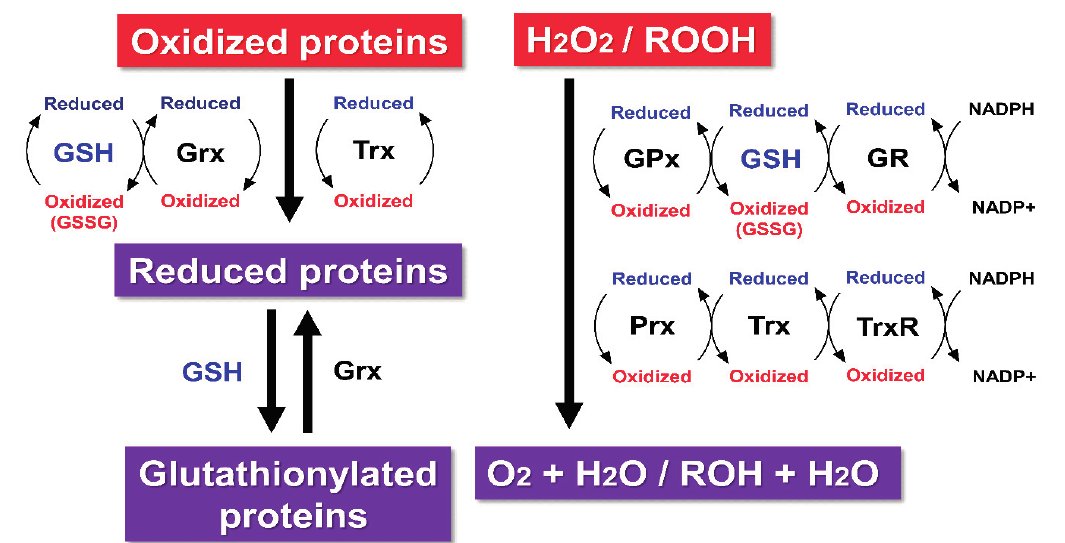
Figure 1. Regulation of the redox homeostasis by glutathione (GSH), thioredoxin (Trx), and glutaredoxin (Grx) systems. Hydrogen peroxide (H 2 O 2 ) and hydroperoxides (ROOH) are catalyzed by GSH peroxidase (GPx) or peroxiredoxin (Prx) to alcohols (ROH) and water. The oxidized form of Trx is reduced back by the reaction with Trx reductase (TrxR), while that of Grx is reduced back by GSH. An oxidized GSH (GSSG) is reduced back to two GSH molecules by the reaction of GSH reductase (GR). Both Trx and Grx reduce protein disulfides. Grx also catalyzes protein